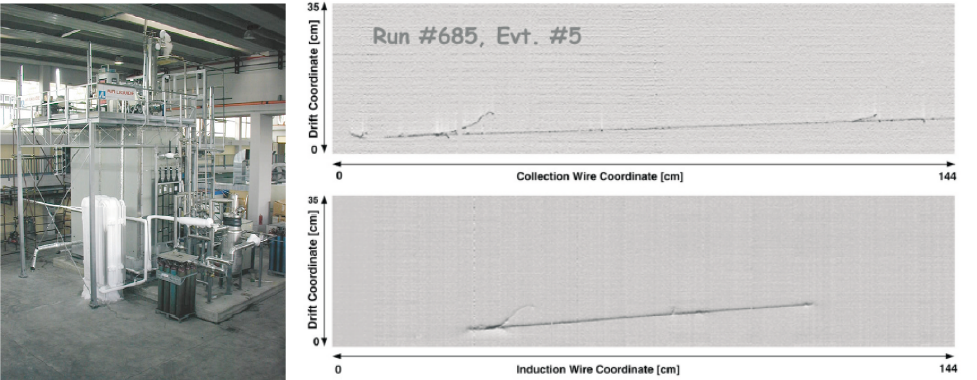
Figure 5. ( Left ): The 10 m 3 detector installed in an external lab at LNGS. ( right ): Cosmic muon crossing the LAr active volume recorded with the 10 m 3 detector at LNGS. A clear δ -ray originating from the muon track is also